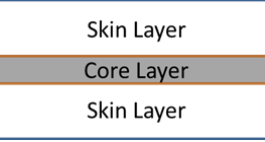
Fig. 5 Structure of an acoustic PVB